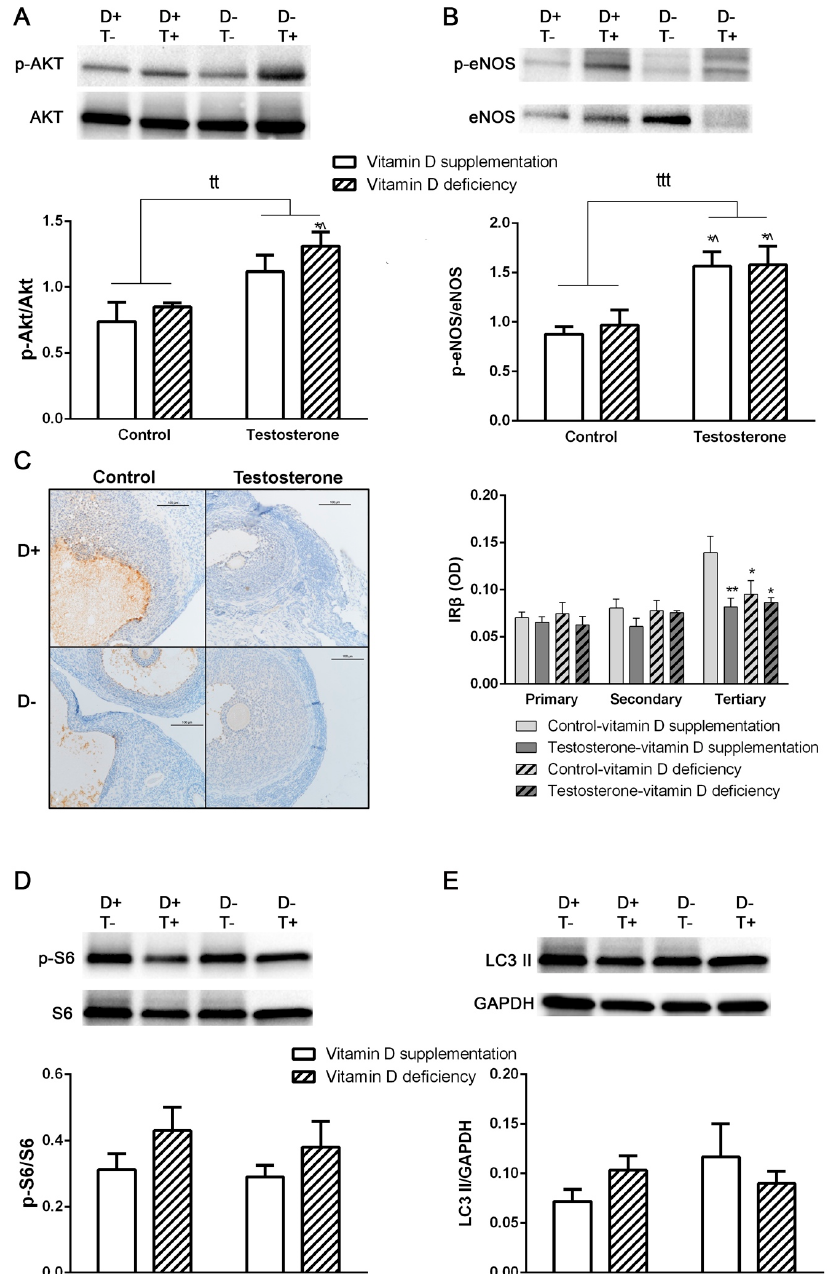
Figure3. Alterationsininsulinsignalingpathwayandautophagyinovariantissue. ( A )Aktphosphorylation in ovarian tissue. ( B ) eNOS phosphorylation in ovarian tissue. ( C ) Immunohistochemical staining of ovarian tissue with anti-IR β antibody. ( D ) Protein S6 phosphorylation in the ovary. ( E ) LC3 II formation in ovarian tissue. For Panel A–B and D–E: Data are presented as mean ± SEM. Two-way (factor 1—vitamin D supplementation vs. vitamin D deficiency, factor 2—control vs. testosterone treatment) ANOVA, tt: p < 0.01 control vs. testosterone treatment, ttt: p < 0,001 control vs. testosterone treatment; Tukey’s post hoc test (comparison of experimental groups) * p < 0.05 vs. D + T– group, ˆ p < 0.01 vs. D–T– group; n = 5–8 in each group. For Panel D: Data are presented as mean ± SEM. Two-way (factor 1—follicle size, factor 2—experimental group) ANOVA; Tukey’s post hoc test (comparison of experimental groups) * p < 0.05 vs. D + T– group among large follicles, ** p < 0.01 vs. D + T– group among large follicles; n = 5–8 in each